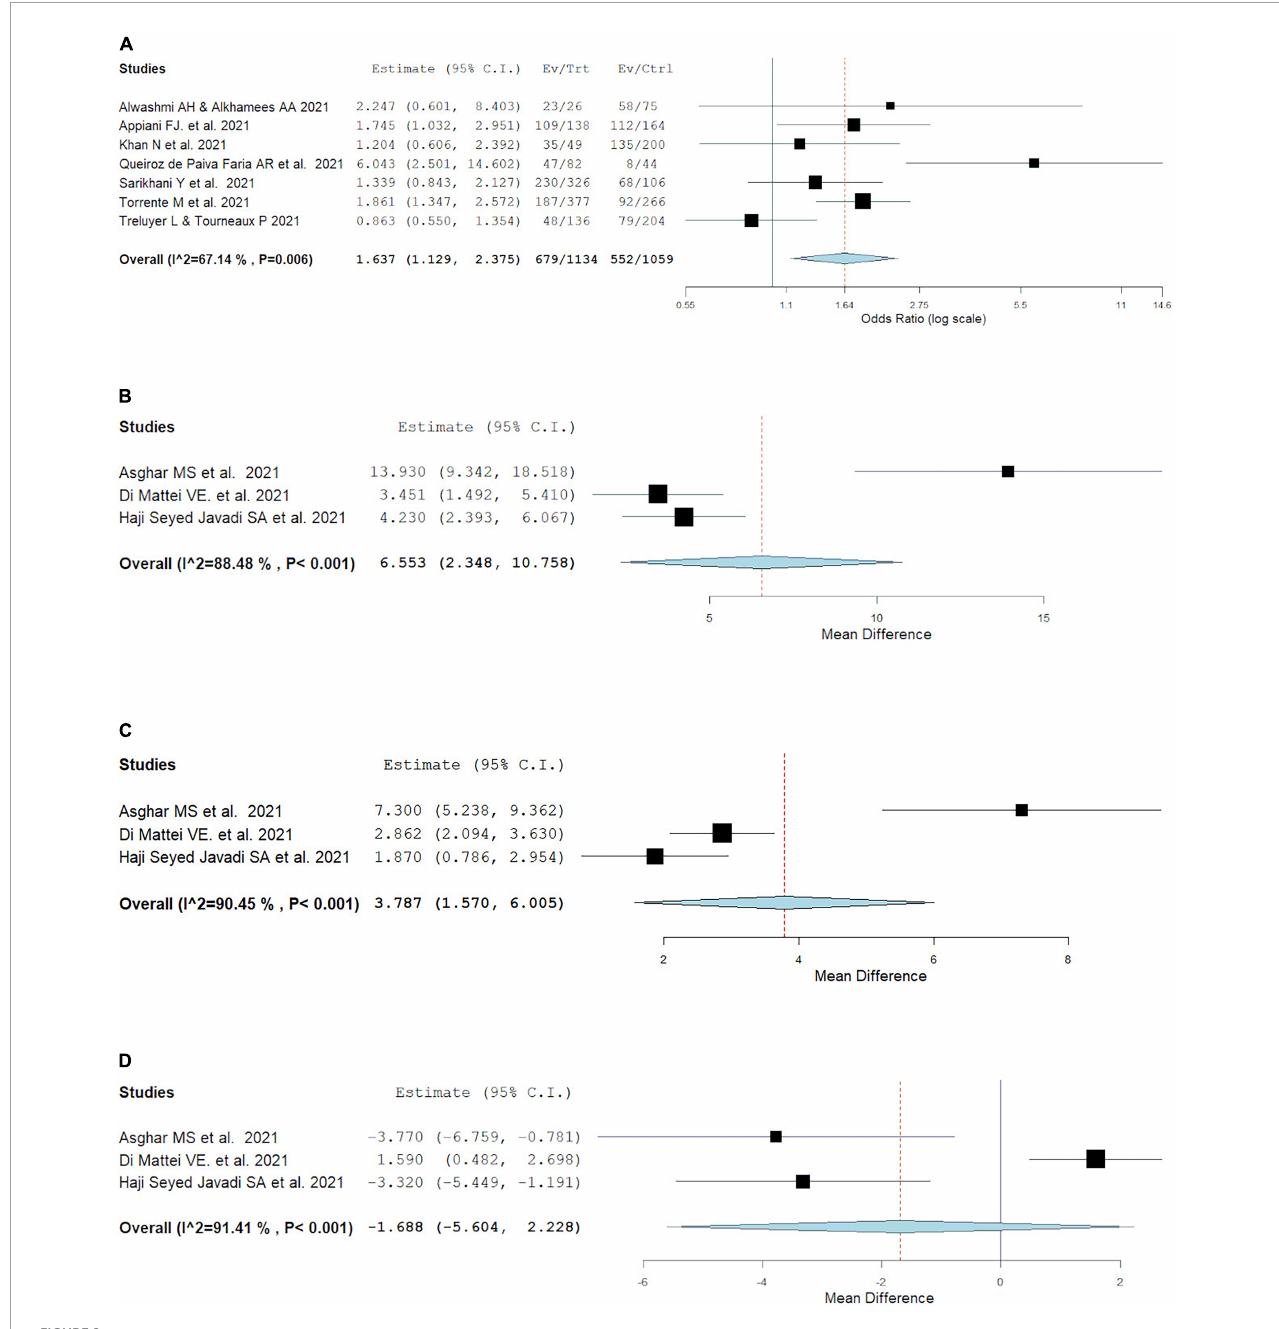
FIGURE2 Pooled estimate of burnout in frontline vs second-line healthcare workers according to Maslach burnout inventrory by (A) overall prevalence, (B) emotional exhaustion prevalence, (C) depersonalization prevalence, (D) personal accomplishment